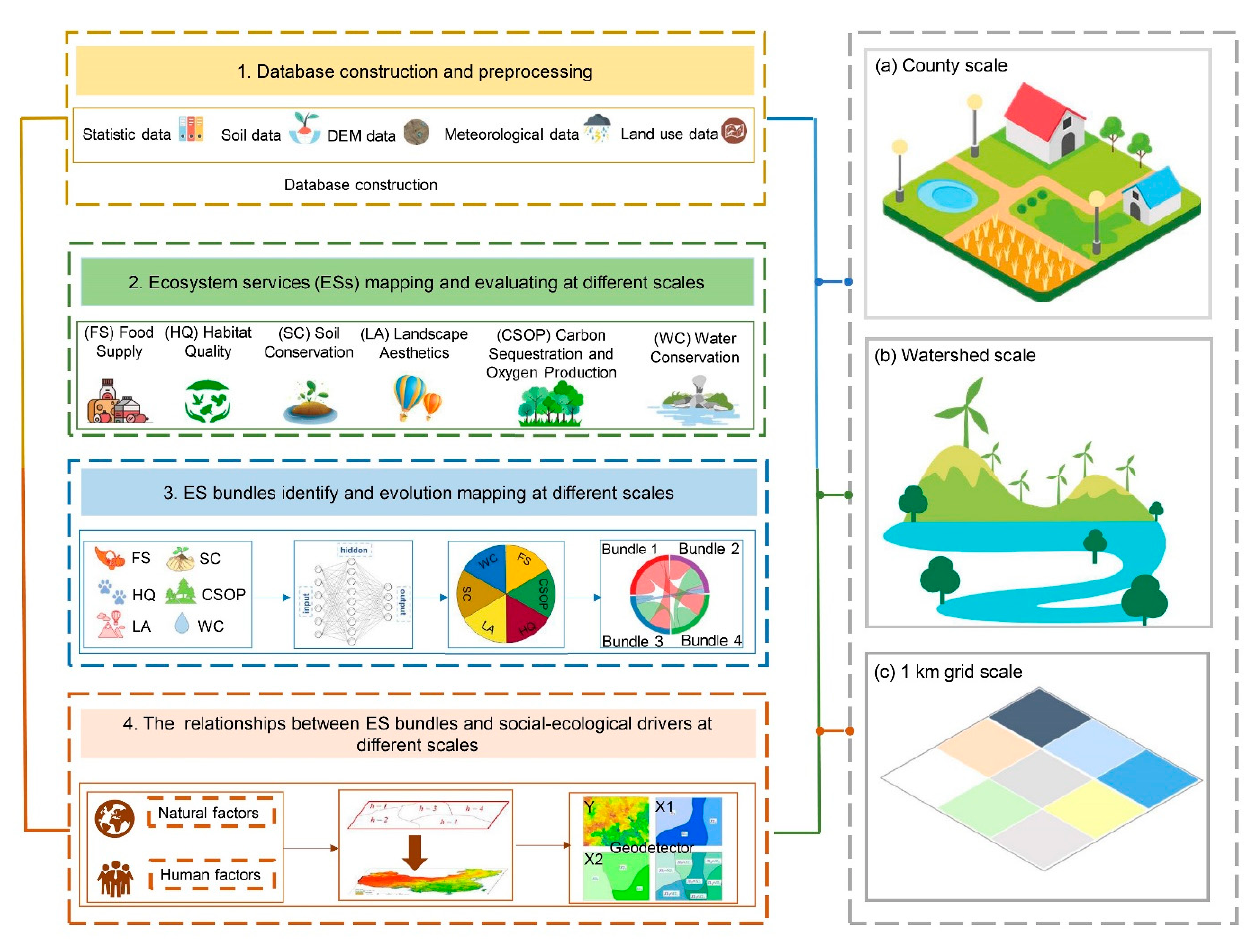
Figure 2. Conceptual research framework.